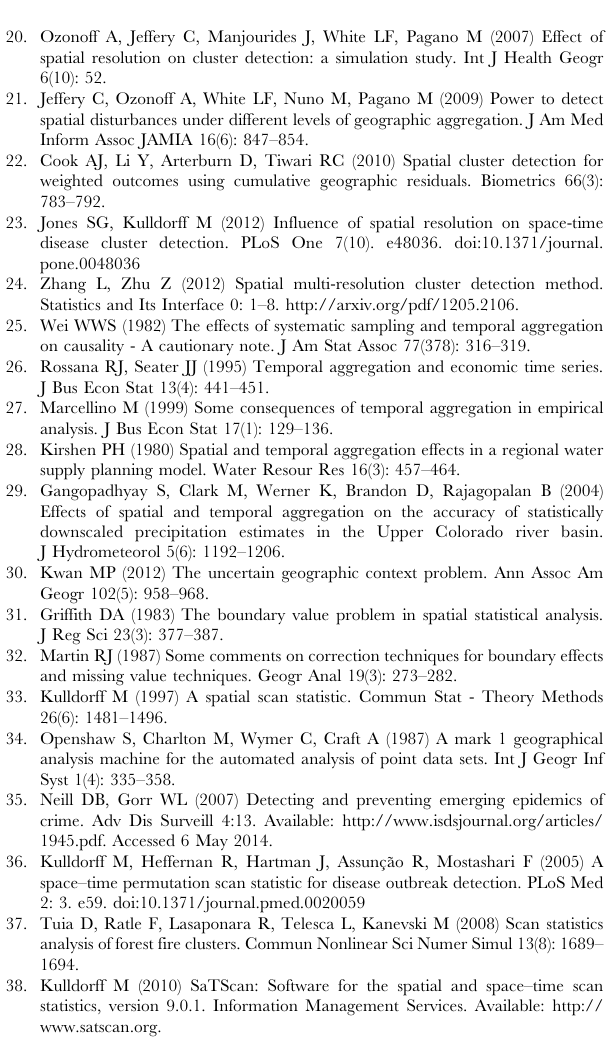
Figure 6. Temporal Boundary Effects (a) ‘‘Burglary-dwellings’’ crime clusters (b) ‘‘Theft-of-shoplifting’’ crime clusters (c) ‘‘Violence- against-persons’’ crime